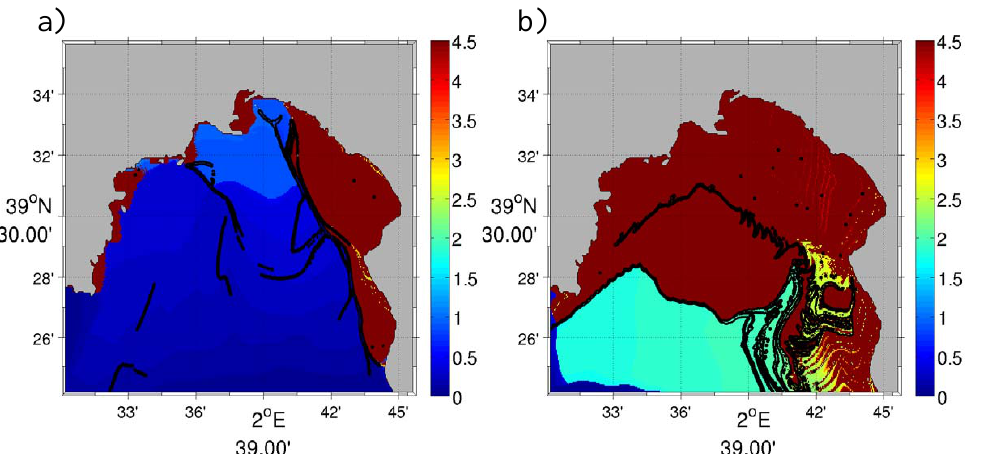
Fig. 9. Snapshots of top values of FSLE (greater than 0 . 5day − 1 ) plotted over residence times. (a) is for backward integration in time, and (b) is for forward integration. Both plots correspond to 19 October at 00:00 (GMT) The color bar units are